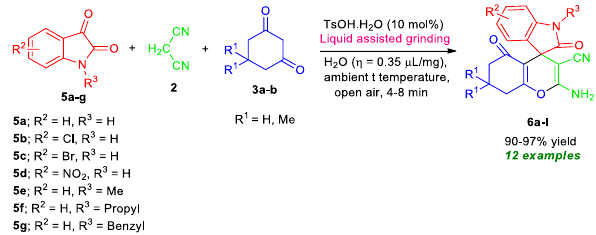
Figure 6. Synthesis of spirooxindoles 6 under the standard conditions.